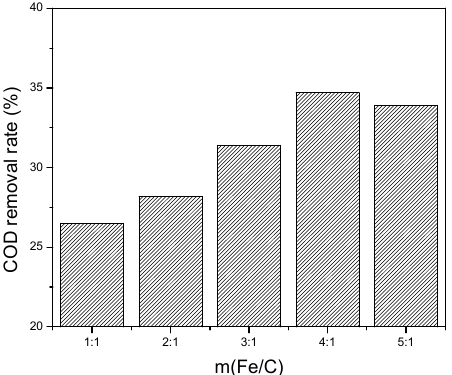
Figure 3. Influence of m(Fe/C) on the COD removal rate.